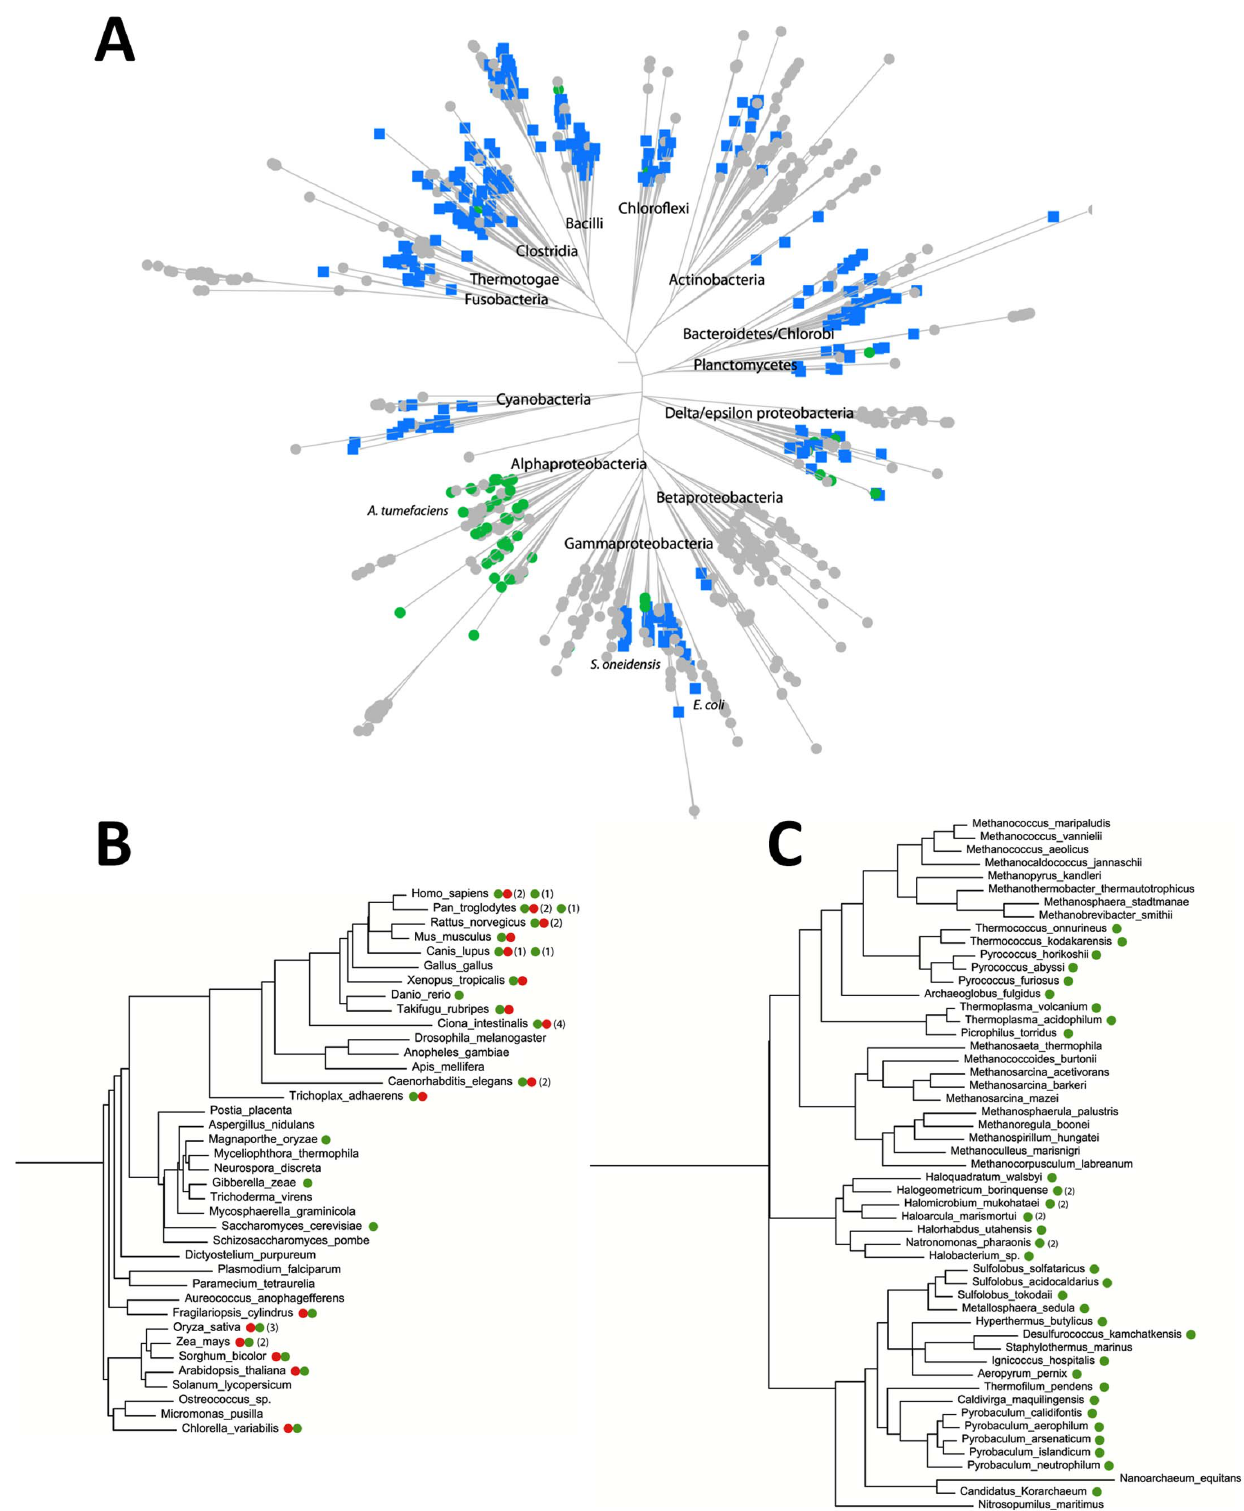
Figure 6. Phylogenetic distribution and domain composition of COG1058. Schematic representation of bacterial (A), eukaryotic (B) and archaeal (C) species trees showing COG1058 genes mapping. Green circle designates the COG1058 gene; the FAD synthase gene is represented by a red circle; the fused COG1058/pncC gene is shown as a blue square. Numbers within squares represents the number of gene copies per genome.